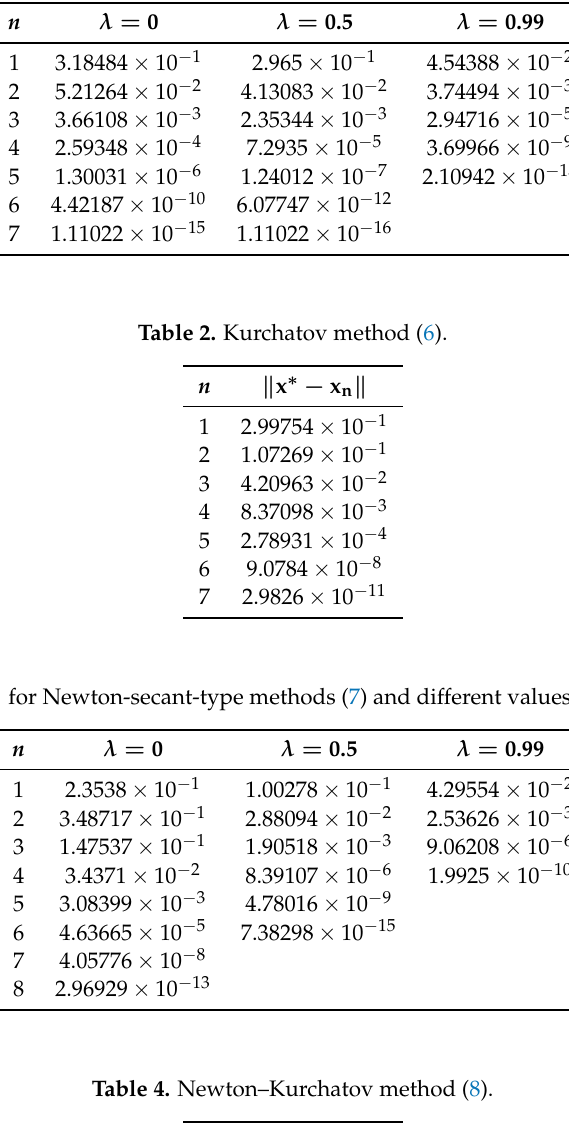
Table 1. (cid:107) x ∗ − x n (cid:107) for secant-type methods (5) and different values of the parameter λ .